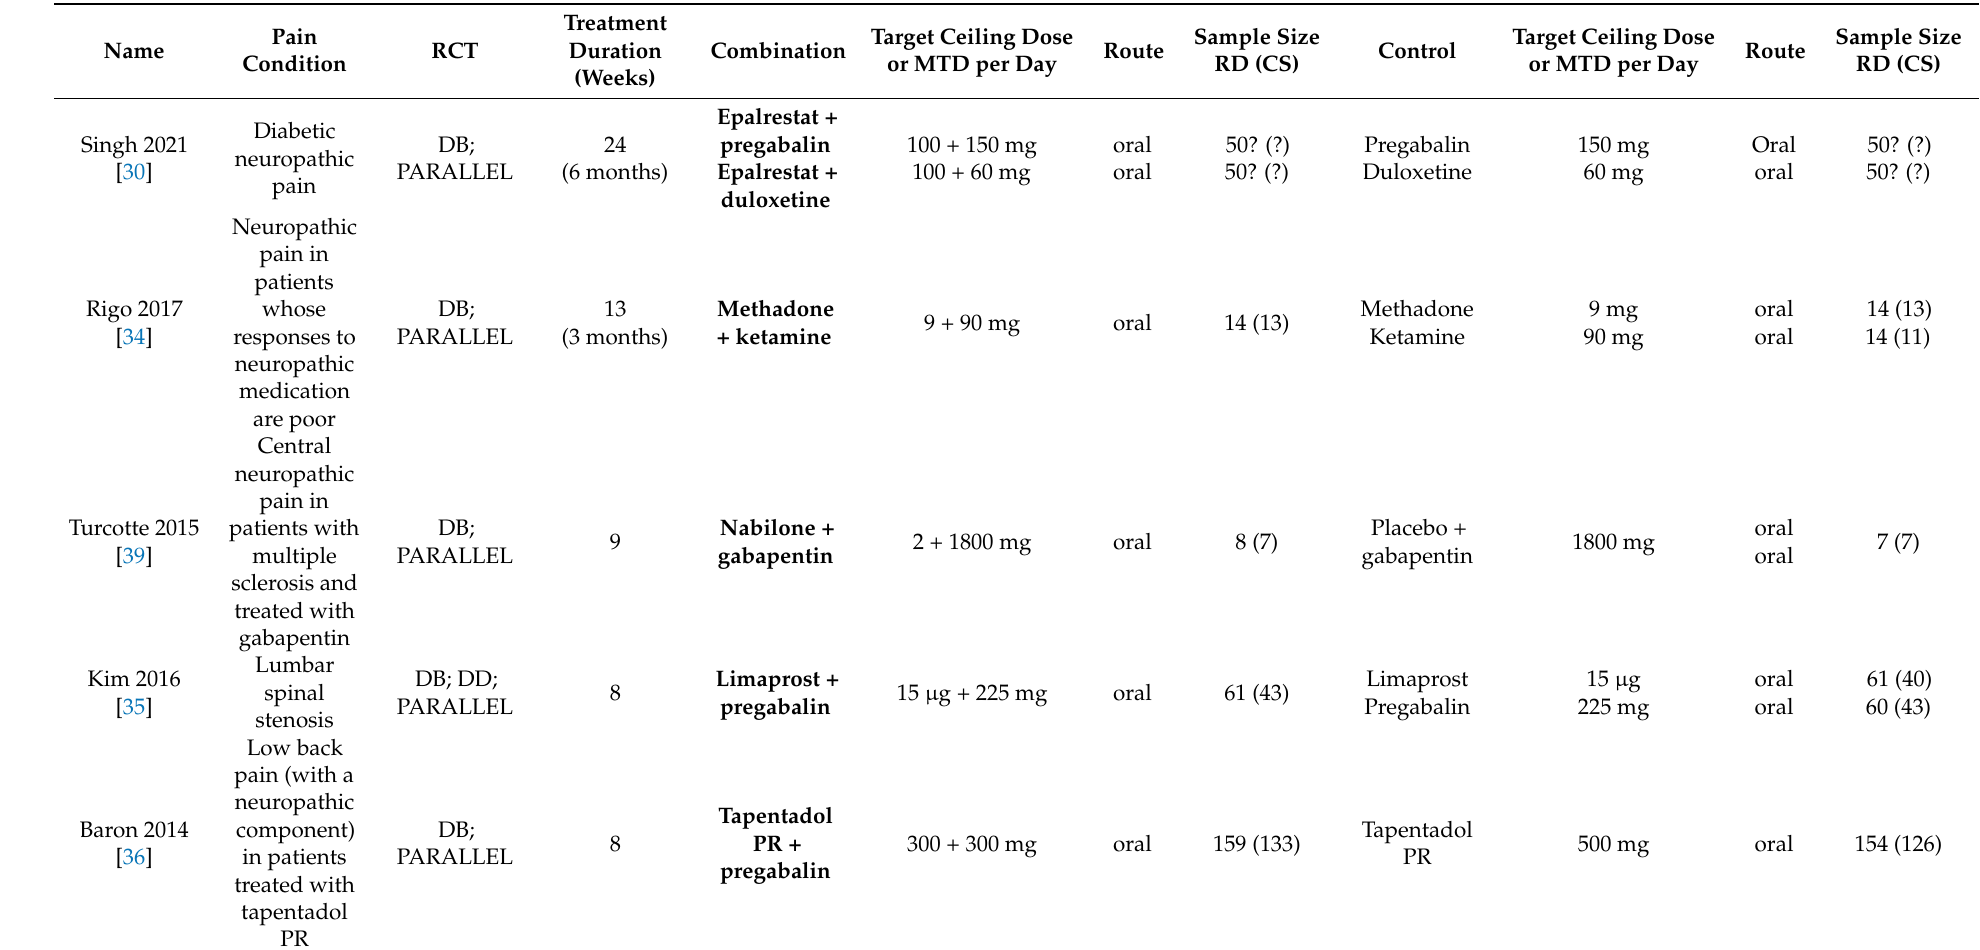
Table 2. Data from the non-selected